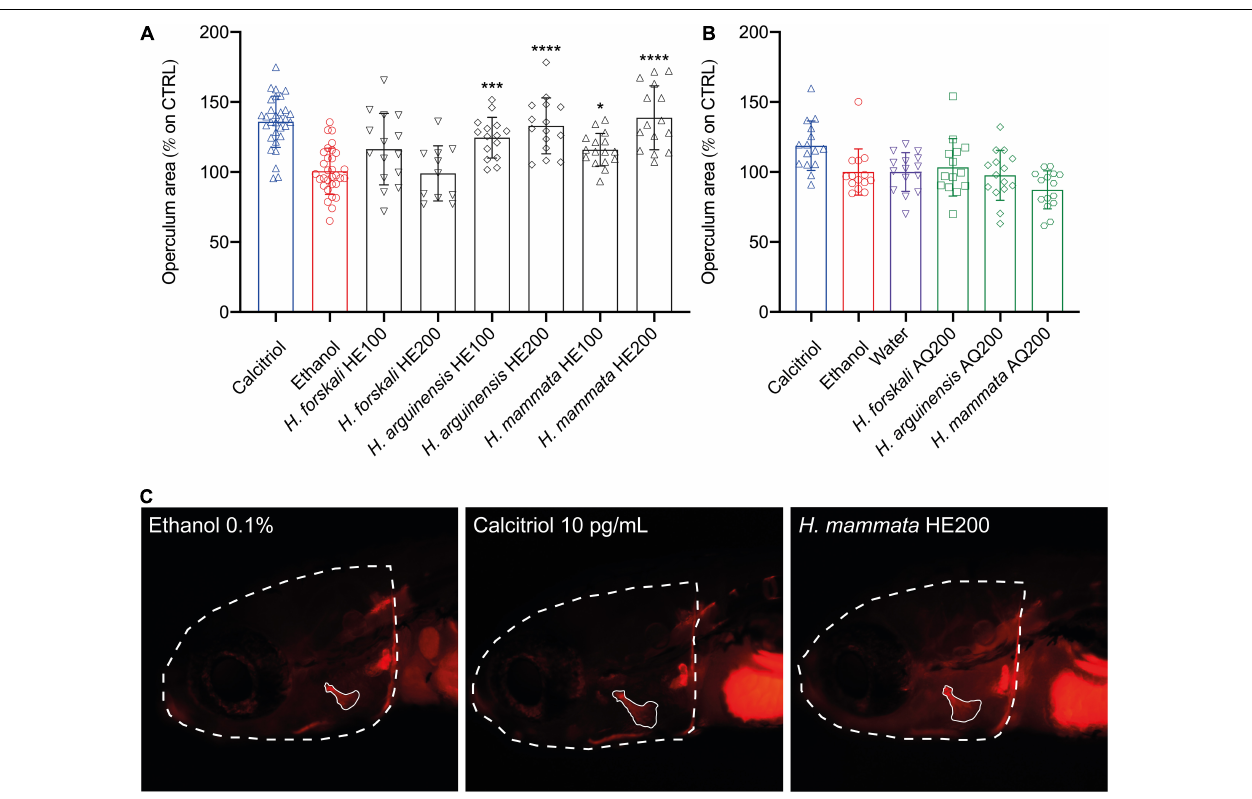
FIGURE 3 | Osteogenic activity of aqueous (A) and hydroethanolic (B) extracts from three species of sea cucumbers in zebrafish larvae. Results are displayed as corrected operculum area (operculum area/head ratio) expressed as percentage of increase over the control. Representative image (C) of a fish treated with the negative control (ethanol), the positive control (Calcitriol 10 pg/mL) and the most powerful osteogenic extracts among holothurians ( H. mammata HE200). Statistical differences among the means were tested through one-way ANOVA followed by Dunnett’s multiple comparison test ( p < 0.05) or, whenever normality and homoscedasticity weren’t met, through a non-parametric test followed by Dunn’s multiple comparison test ( p < 0.05). P -values are indicated as follow: 0.0332 (*), 0.0002 (***), < 0.0001 (****). HE, hydroethanolic extracts, AQ, aqueous extracts, 100–100 µ g/mL, 200–200 µ